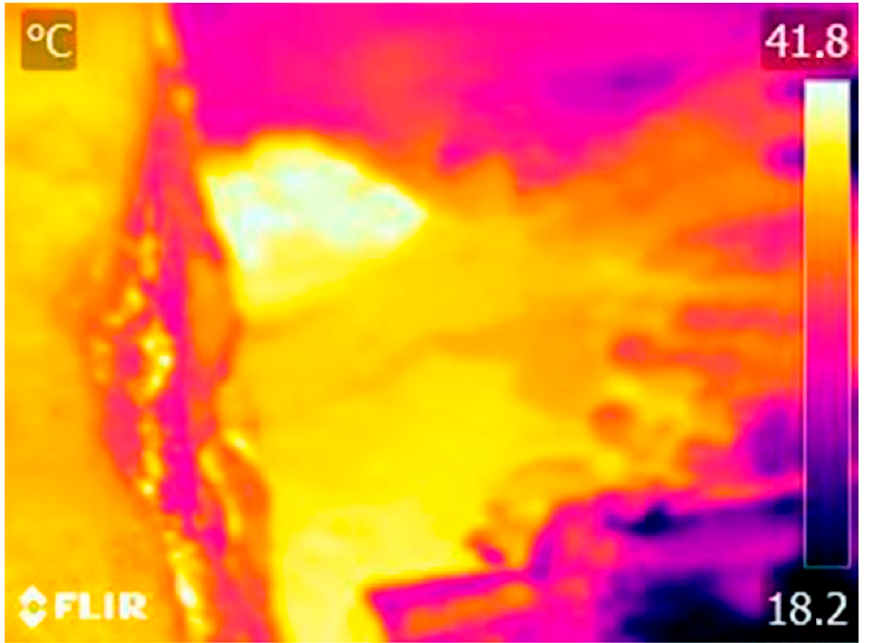
Figure 15. Thermal image of the area with potential interest taken with a FLIR E40 handheld sensor to validate the final results.